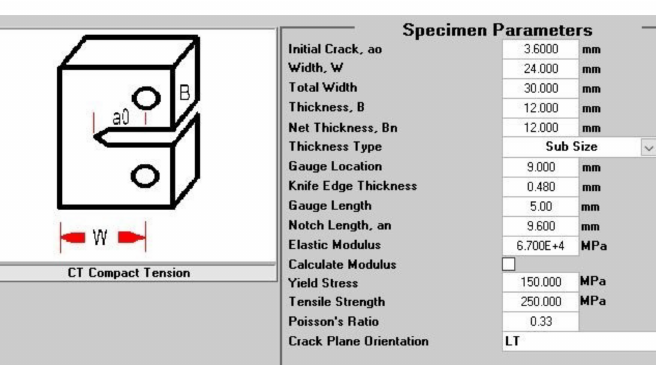
Figure 5. Setting specimen